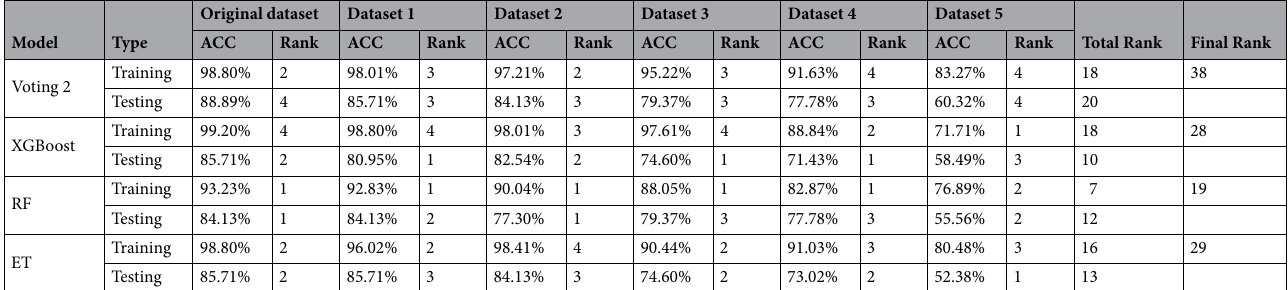
Table 15. The rank system for six datasets with different input